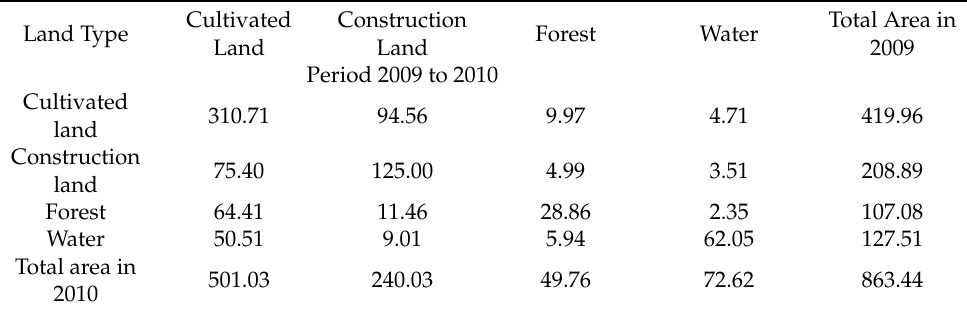
Table 10. Land-use transition matrix of the research